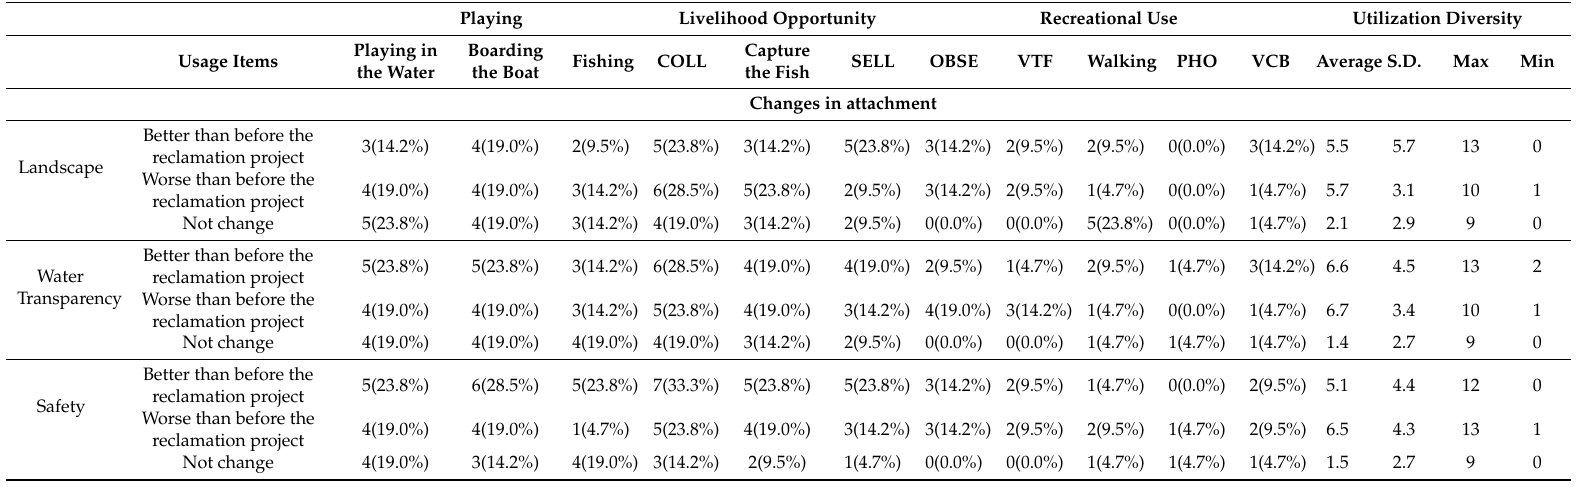
Table A6. Changes in attachment towards the Fukushima-gata lagoon and actual use situation of the Fukushima-gata lagoon before reclamation project (n = 21). Playing